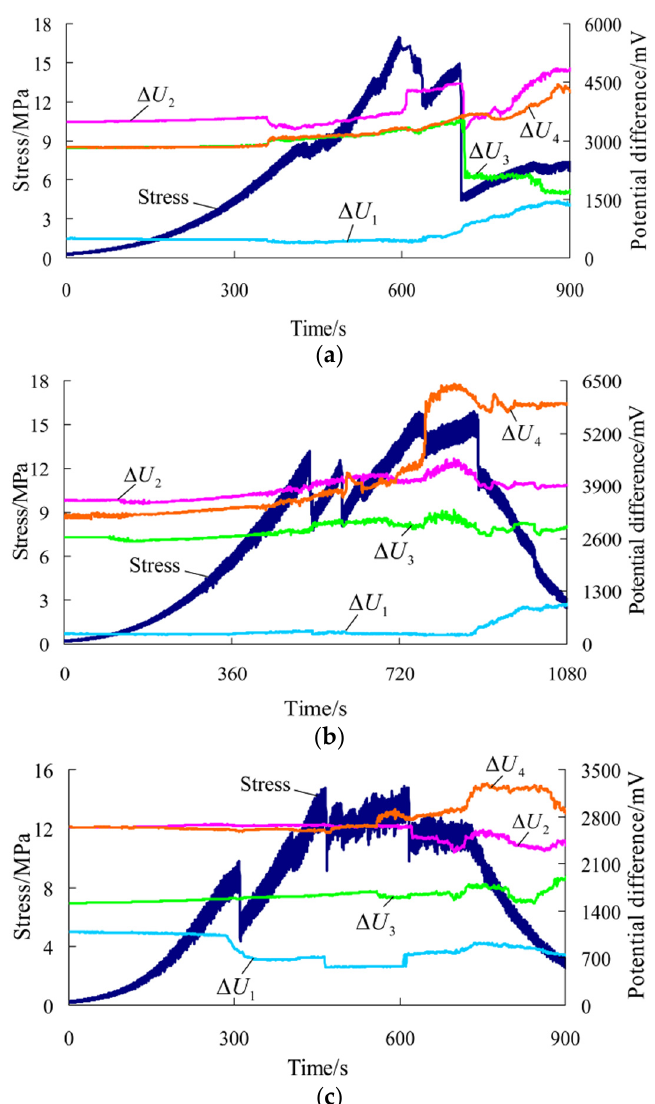
Figure 4. Stress ‐ time curve and time ‐ varying curve of the potential difference in each direction during the whole process of uniaxial compression for rock samples normal to the bedding direction. ( a ) Rock sample 5-1; ( b ) Rock sample 5-2; ( c ) Rock sample 6-4.